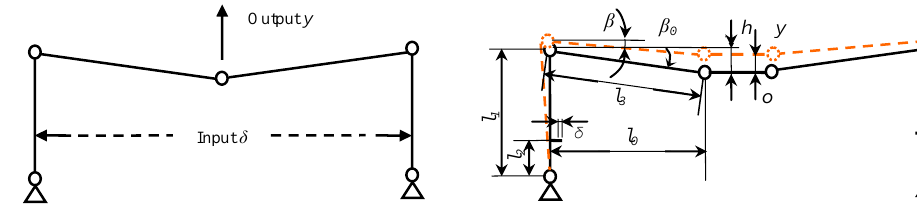
Figure 1. Symmetric five-bar